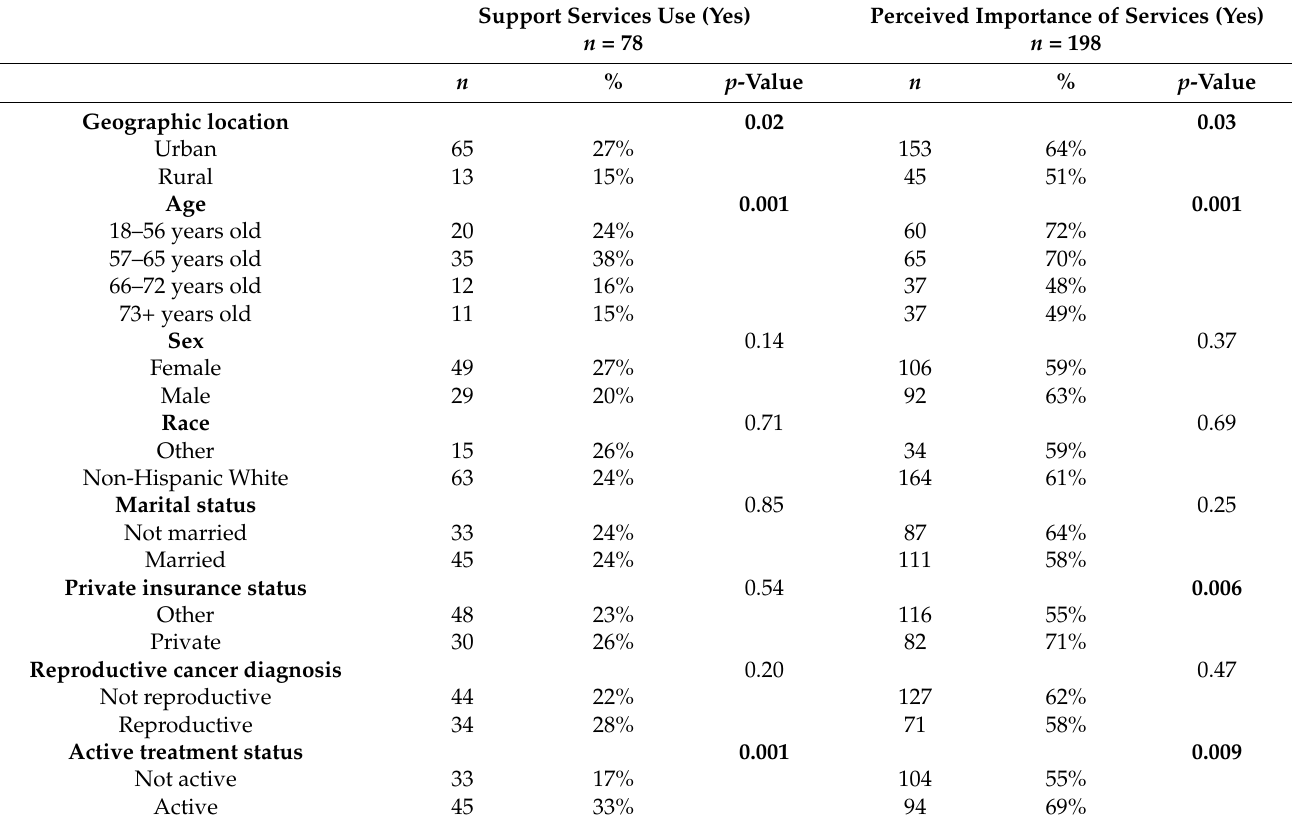
Table 2. Crude analyses to assess relationships between demographic, cancer-related, and severe support needs factors with support services use and perceived importance of support